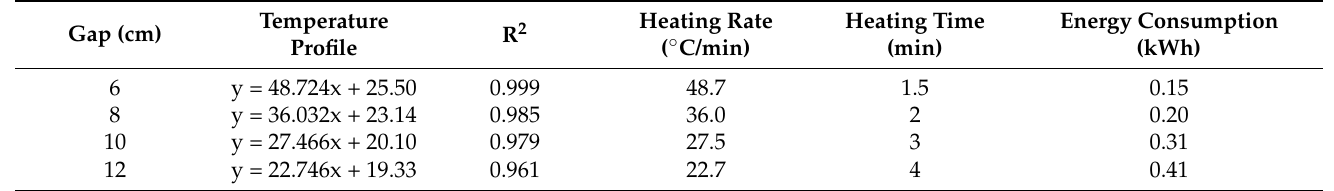
Table 1. The temperature profile equation, heating rate, heating time and energy consumption of rice bran by RF treatment. Gap (cm)